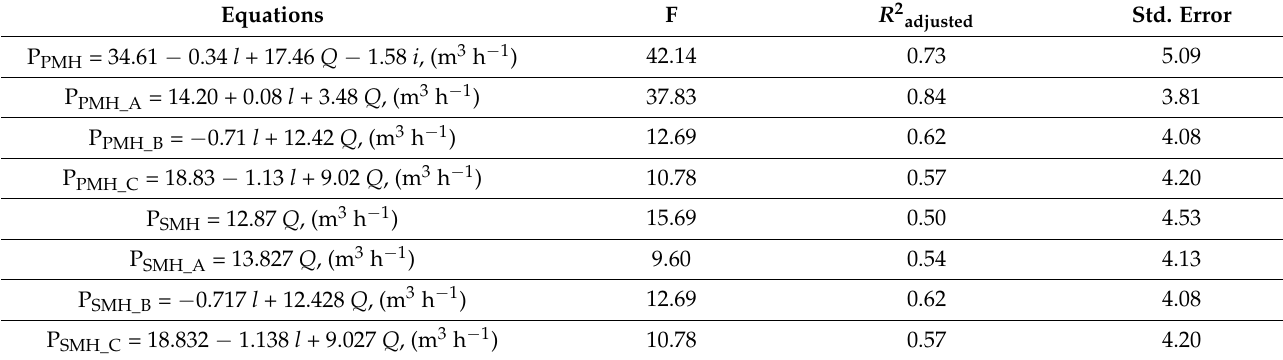
Table 6. Summary of the productivity models developed for the site and corridor conditions.